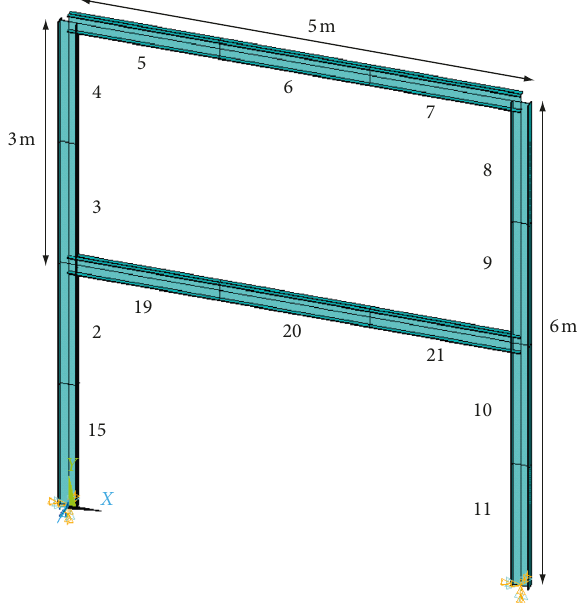
Figure 4: Steel frame considered in the example. Table 1: Stiffness matrix determinant ratios.